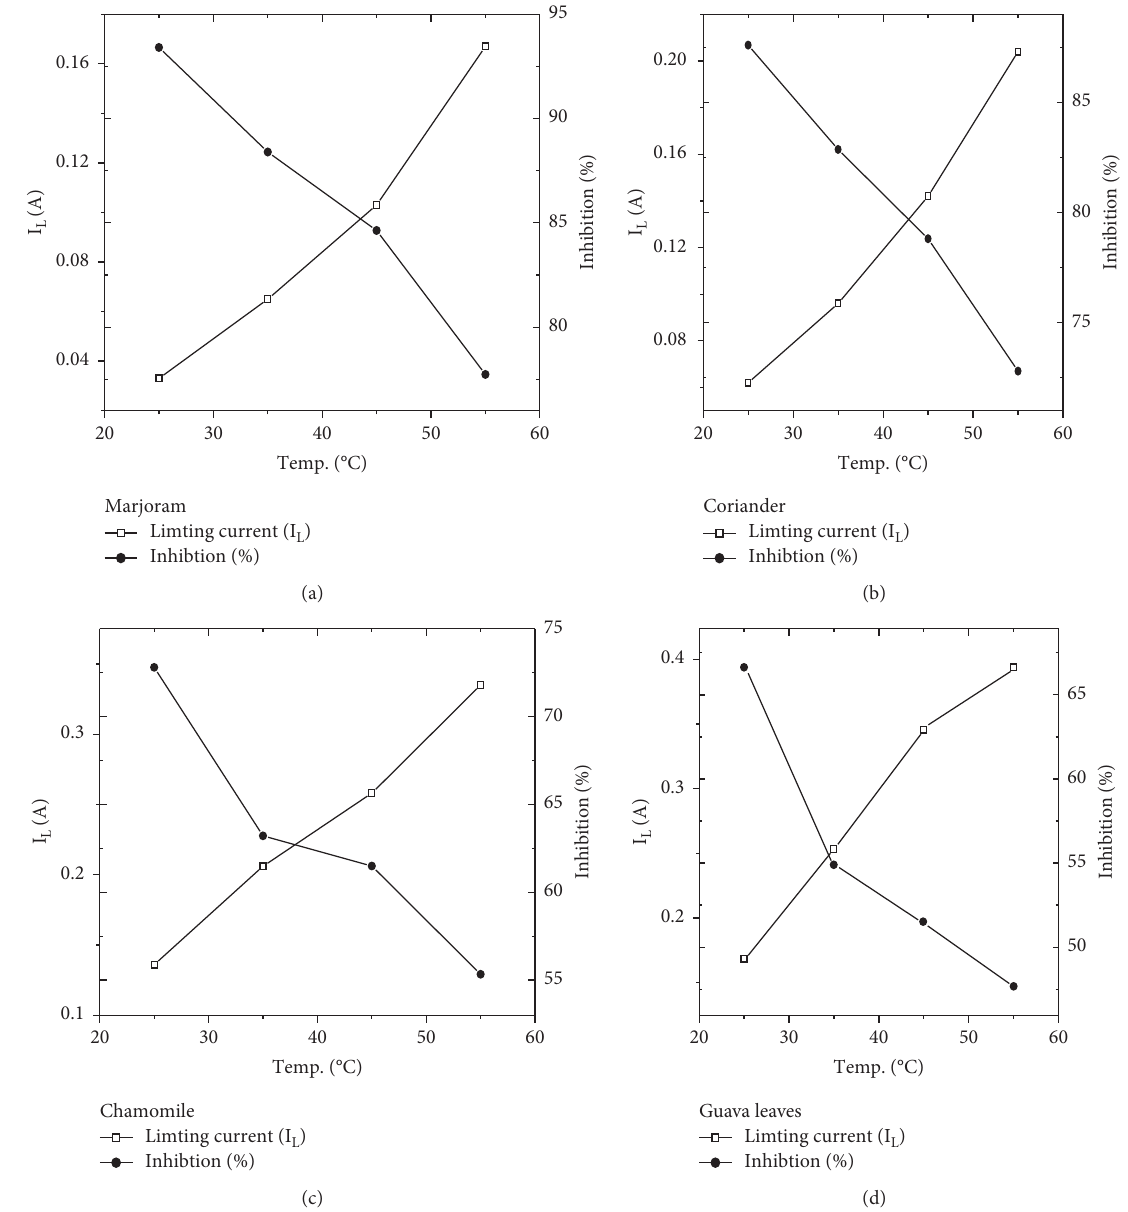
Figure 8: Variation of limiting current ( I methanolic plant